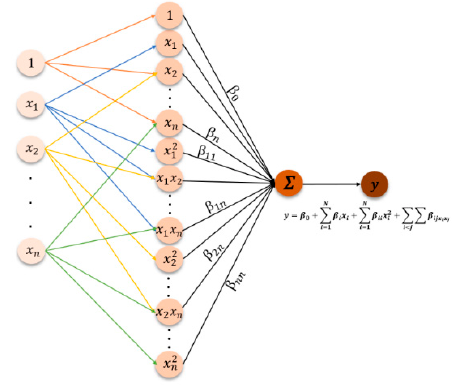
Figure 6. Schematic view of the RSM model. Table 2. Levels and code of the four factors.